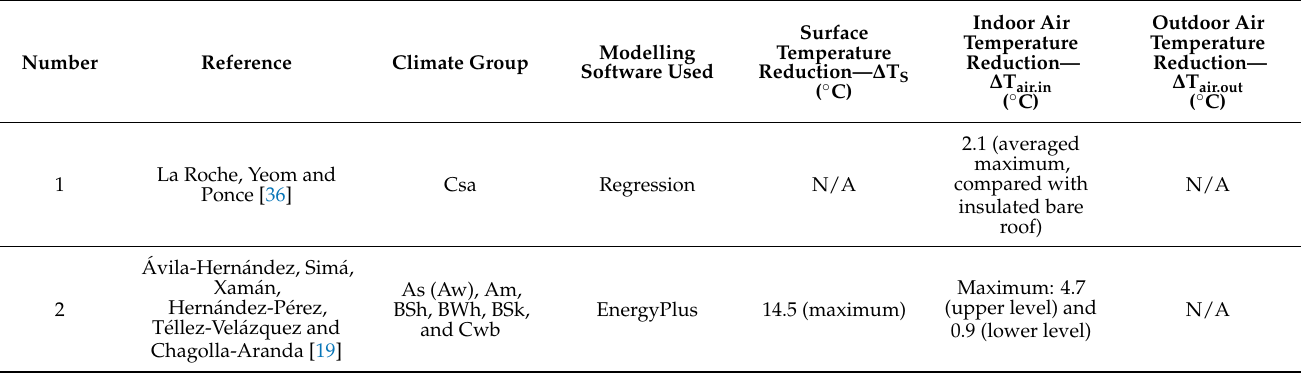
Table 2. Quantification of Human Thermal Comfort improvement by green